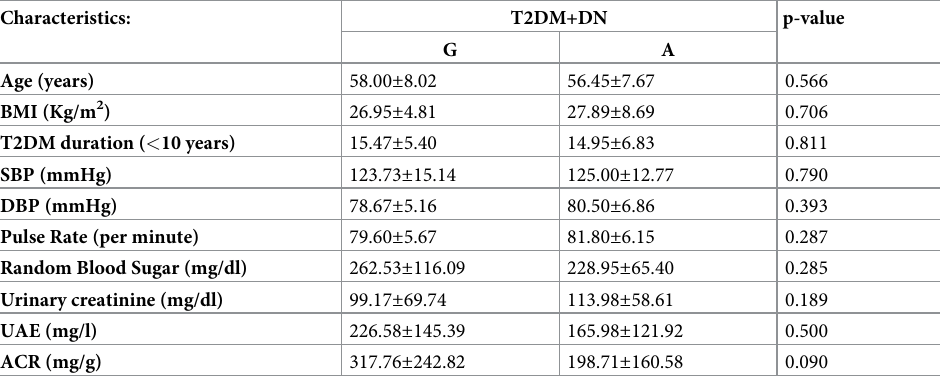
Analysis by independent sample t-test. � significant at the level of 0.05 and �� highly significant at the level of